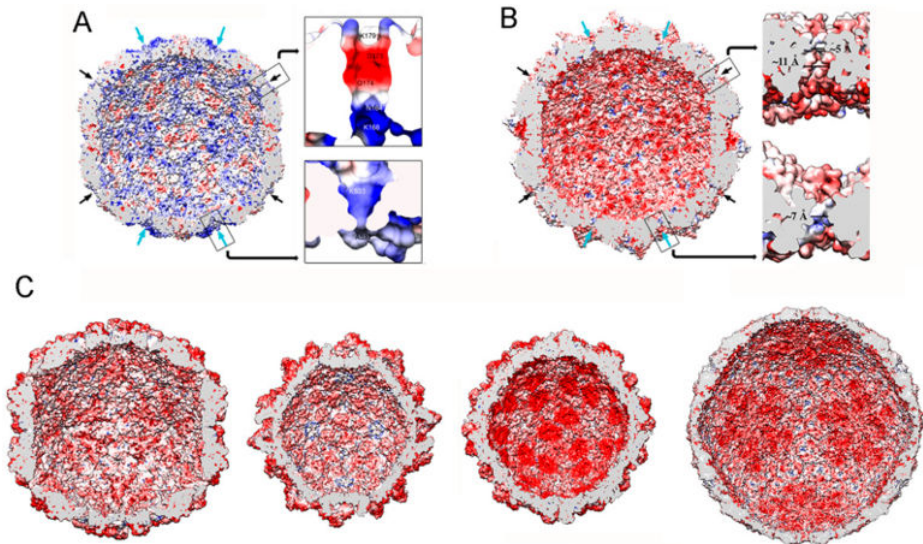
Figure 7. dsRNA virus T = 1 capsid inner surfaces with electrostatic potentials. ( A ) PcV and ( B ) RnQV1 capsid inner surfaces viewed along a two-fold axis of icosahedral symmetry. The inner surface charge representations of these capsids show the distribution of negative (red) and positive (blue) charges. Note the numerous electropositive areas in PcV. Arrows indicate the capsid pores at the five-fold (black) and three-fold (blue) axes. Boxes: magnified views of the five- (top) and three-fold (bottom) pores showing charge distribution on the channel walls. ( C ) T = 1 capsids of ScV-L-A, PsV-Fe, rabbit picobirnavirus, and rotavirus (from left to right), viewed along a two-fold axis of icosahedral symmetry. dsRNA and packaged proteins (such as RNA polymerases) were removed